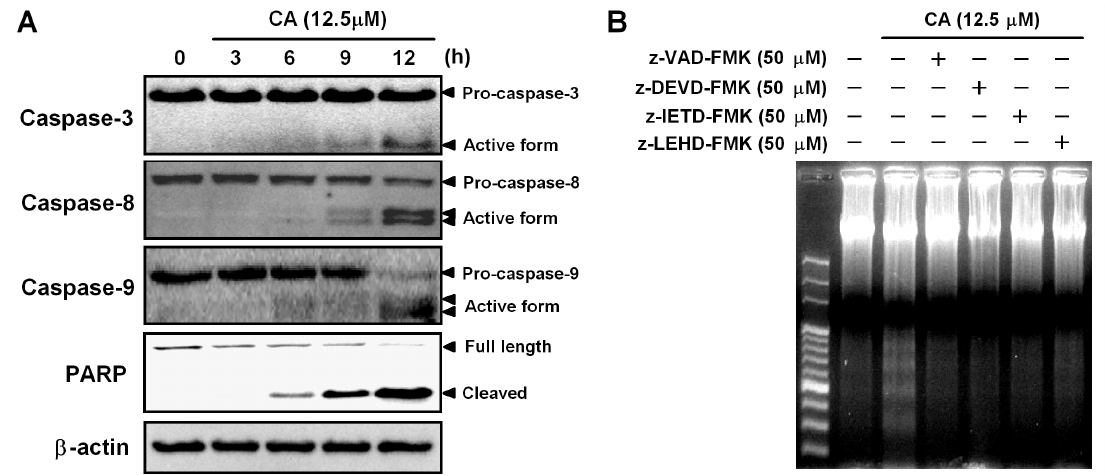
Figure 5. Involvement of the caspase cascade in CA-induced apoptosis. ( A ) Effect of CA on the activation of caspase-3, -8, -9 and PARP cleavage. HL-60 cells were treated with 12.5 μ M CA for the times indicated. The cells were lysed, and the caspase-3, -8, -9, PARP and β -actin protein levels were determined by Western blotting. β -actin was used as the loading control; ( B ) The effect of caspase inhibitors on CA-induced DNA fragmentation. After pretreatment with 50 μ M caspase inhibitors for 1 h, HL-60 cells were treated with 12.5 μ M CA for 24 h. DNA fragmentation was analyzed by agarose gel electrophoresis. The data shown are representative of three independent experiments with similar